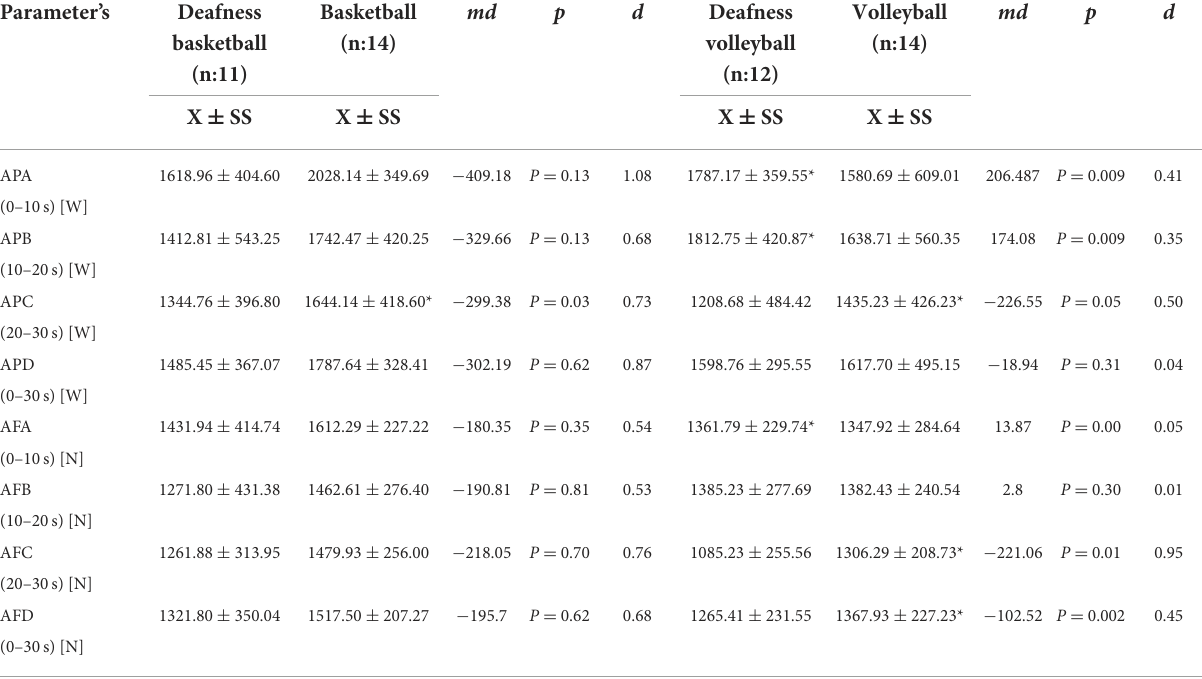
TABLE 3 Comparison of average power and force of deaf and non-deaf basketball/volleyball players.